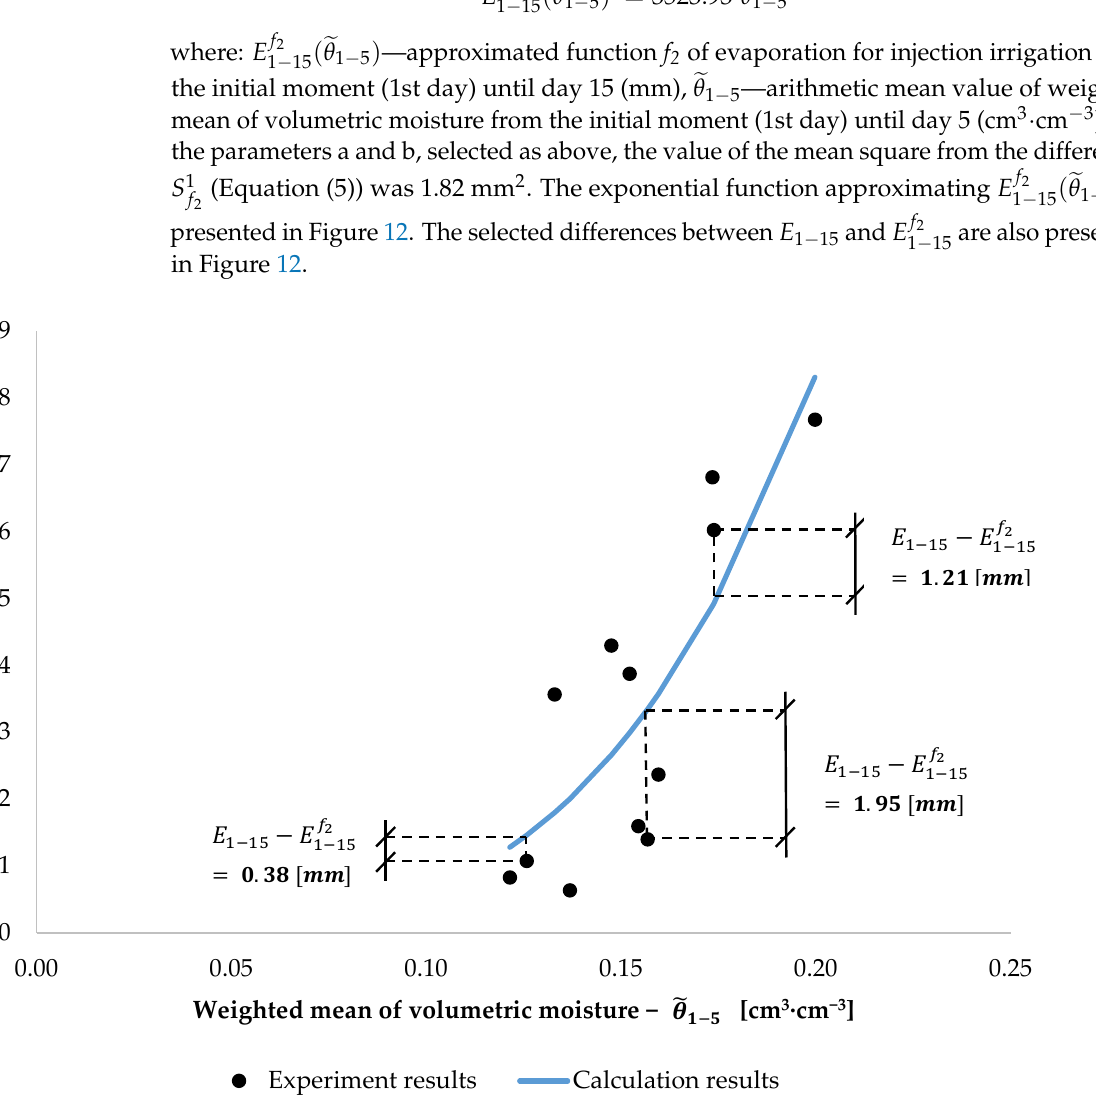
Figure 12. The value of 15-day evaporation, E f 2 1 − 15 , versus the weighted mean of volumetric moisture from the moment of injection (day 1) to day 5: (cid:101) θ 1 − 5 .